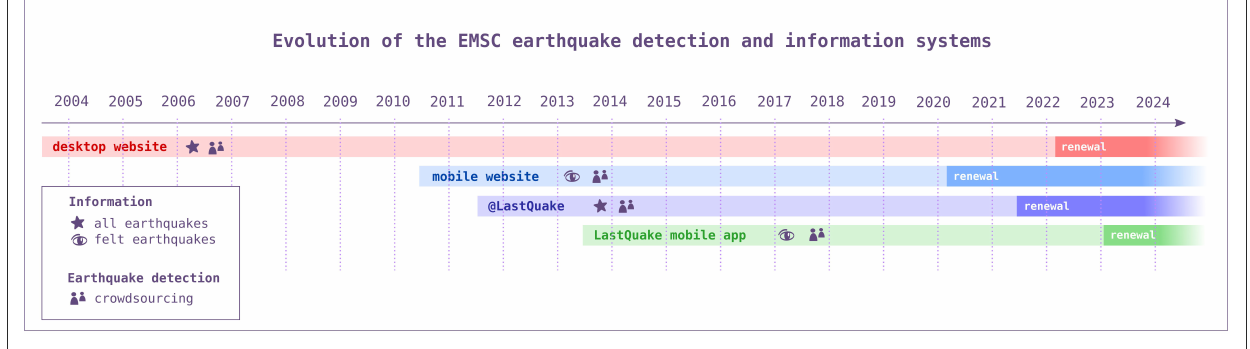
FIGURE1 Evolution of the different components of the LastQuake information and crowdsourcing system, along with their principal individual features. The website for desktops provides data for all earthquakes (felt and not felt) while the other components target eyewitnesses and are focused on felt and damaging earthquakes. For the sake of completeness, there is also a Telegram account that publishes the same messages as the @LastQuake Twitter bot but more details are not deemed necessary because of its limited audience and the absence of interactions with